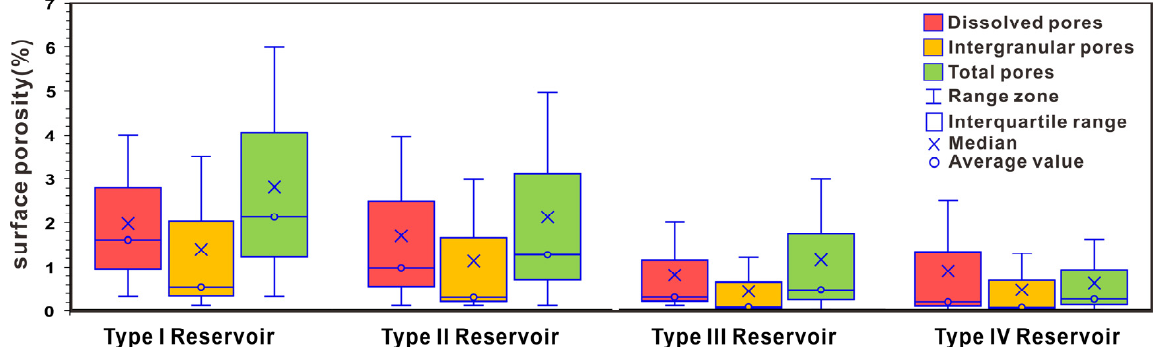
Figure 11. Surface porosity of dissolved pores, intergranular pores, and total pores of different types of reservoirs.